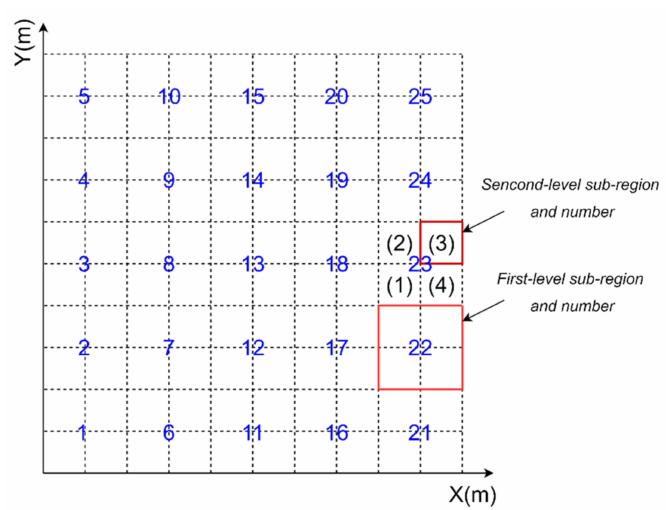
Figure 1. Environment map.